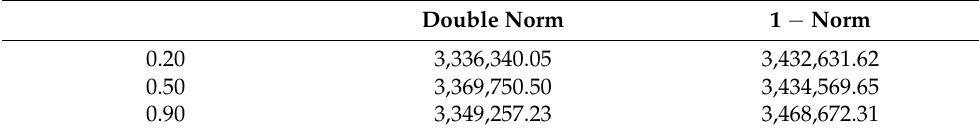
Table 19. Comparison of the results of Cases 1 and 8.